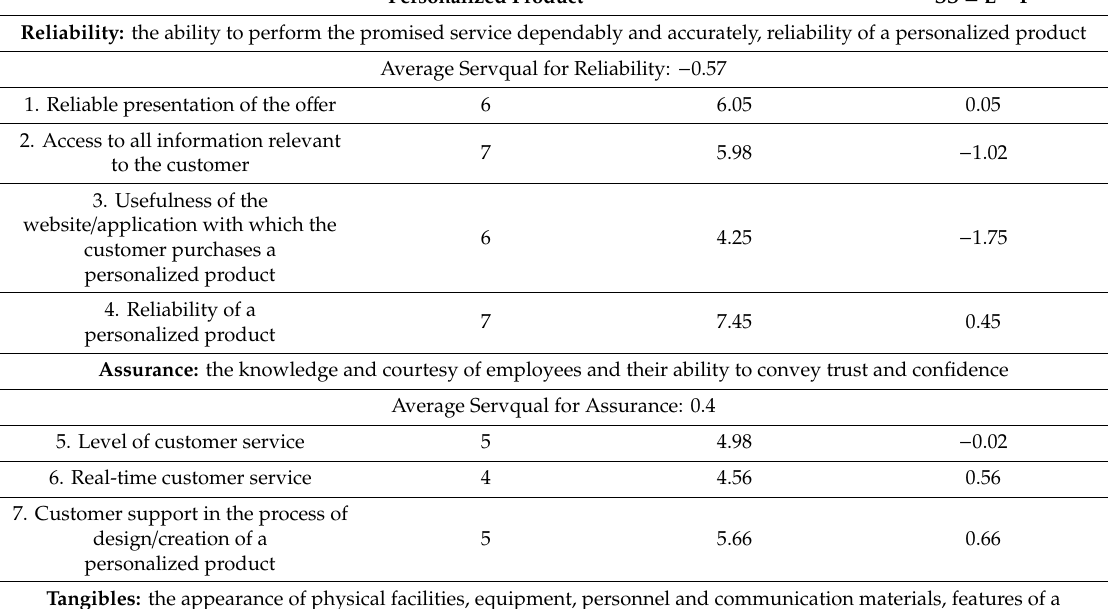
Table 2. Expected and perceived satisfaction with purchasing a personalized product.